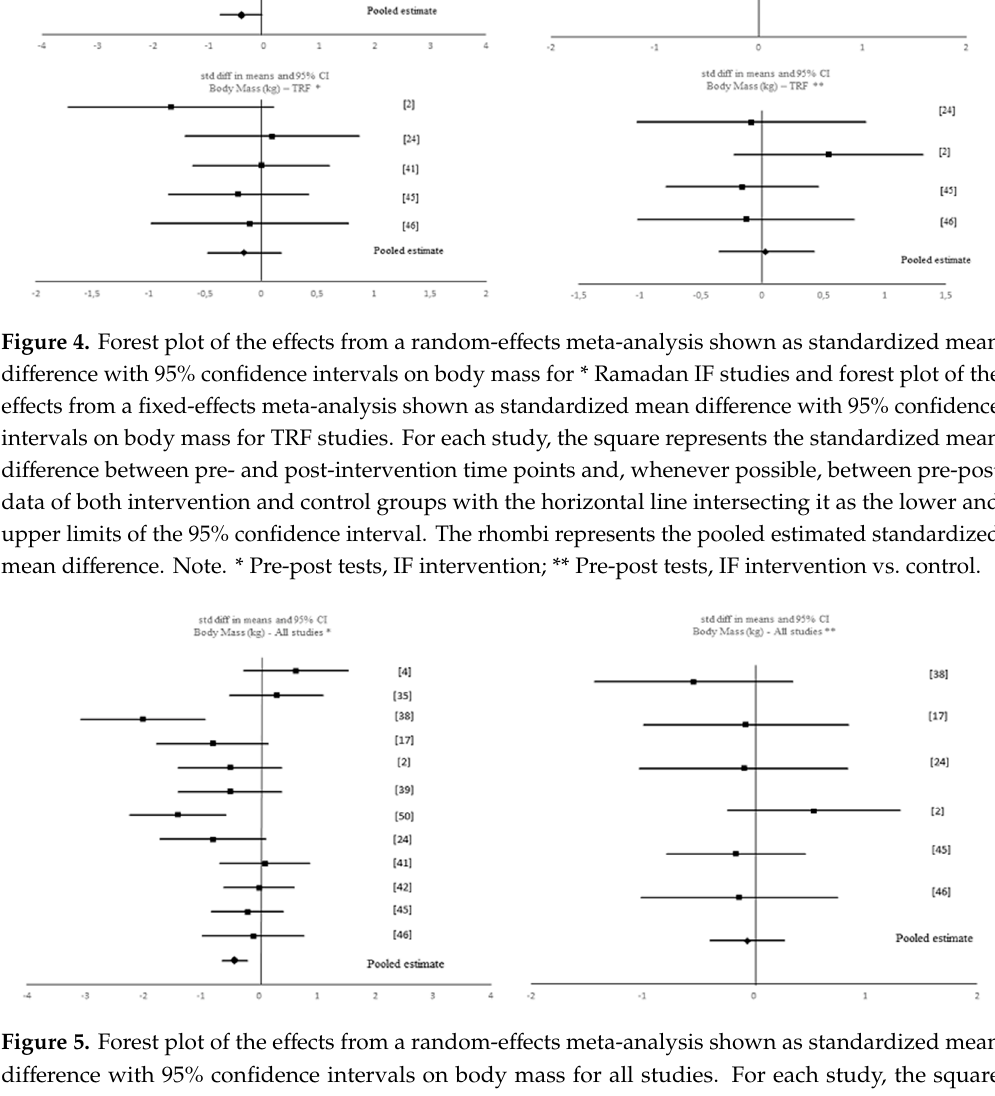
Figure 6. Forest plot of the effects from a fixed-effects meta-analysis shown as standardized mean difference with 95% confidence intervals on relative fat mass for all studies and for only Ramadan IF studies. For each study, the square represents the standardized mean difference between pre- and post-intervention time points and, whenever possible, between pre-post data of both intervention and control groups with the horizontal line intersecting it as the lower and upper limits of the 95% confidence interval. The rhombi represents the pooled estimated standardized mean difference. Note. * Pre-post tests, IF intervention; ** Pre-post tests, IF intervention vs. control. 4. Discussion